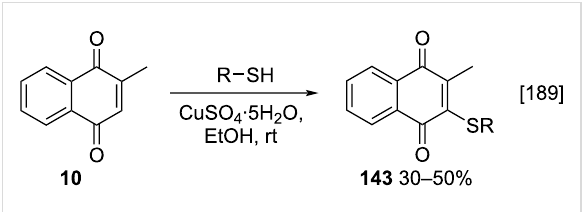
Scheme 51: Synthesis of menadione analogues functionalized with